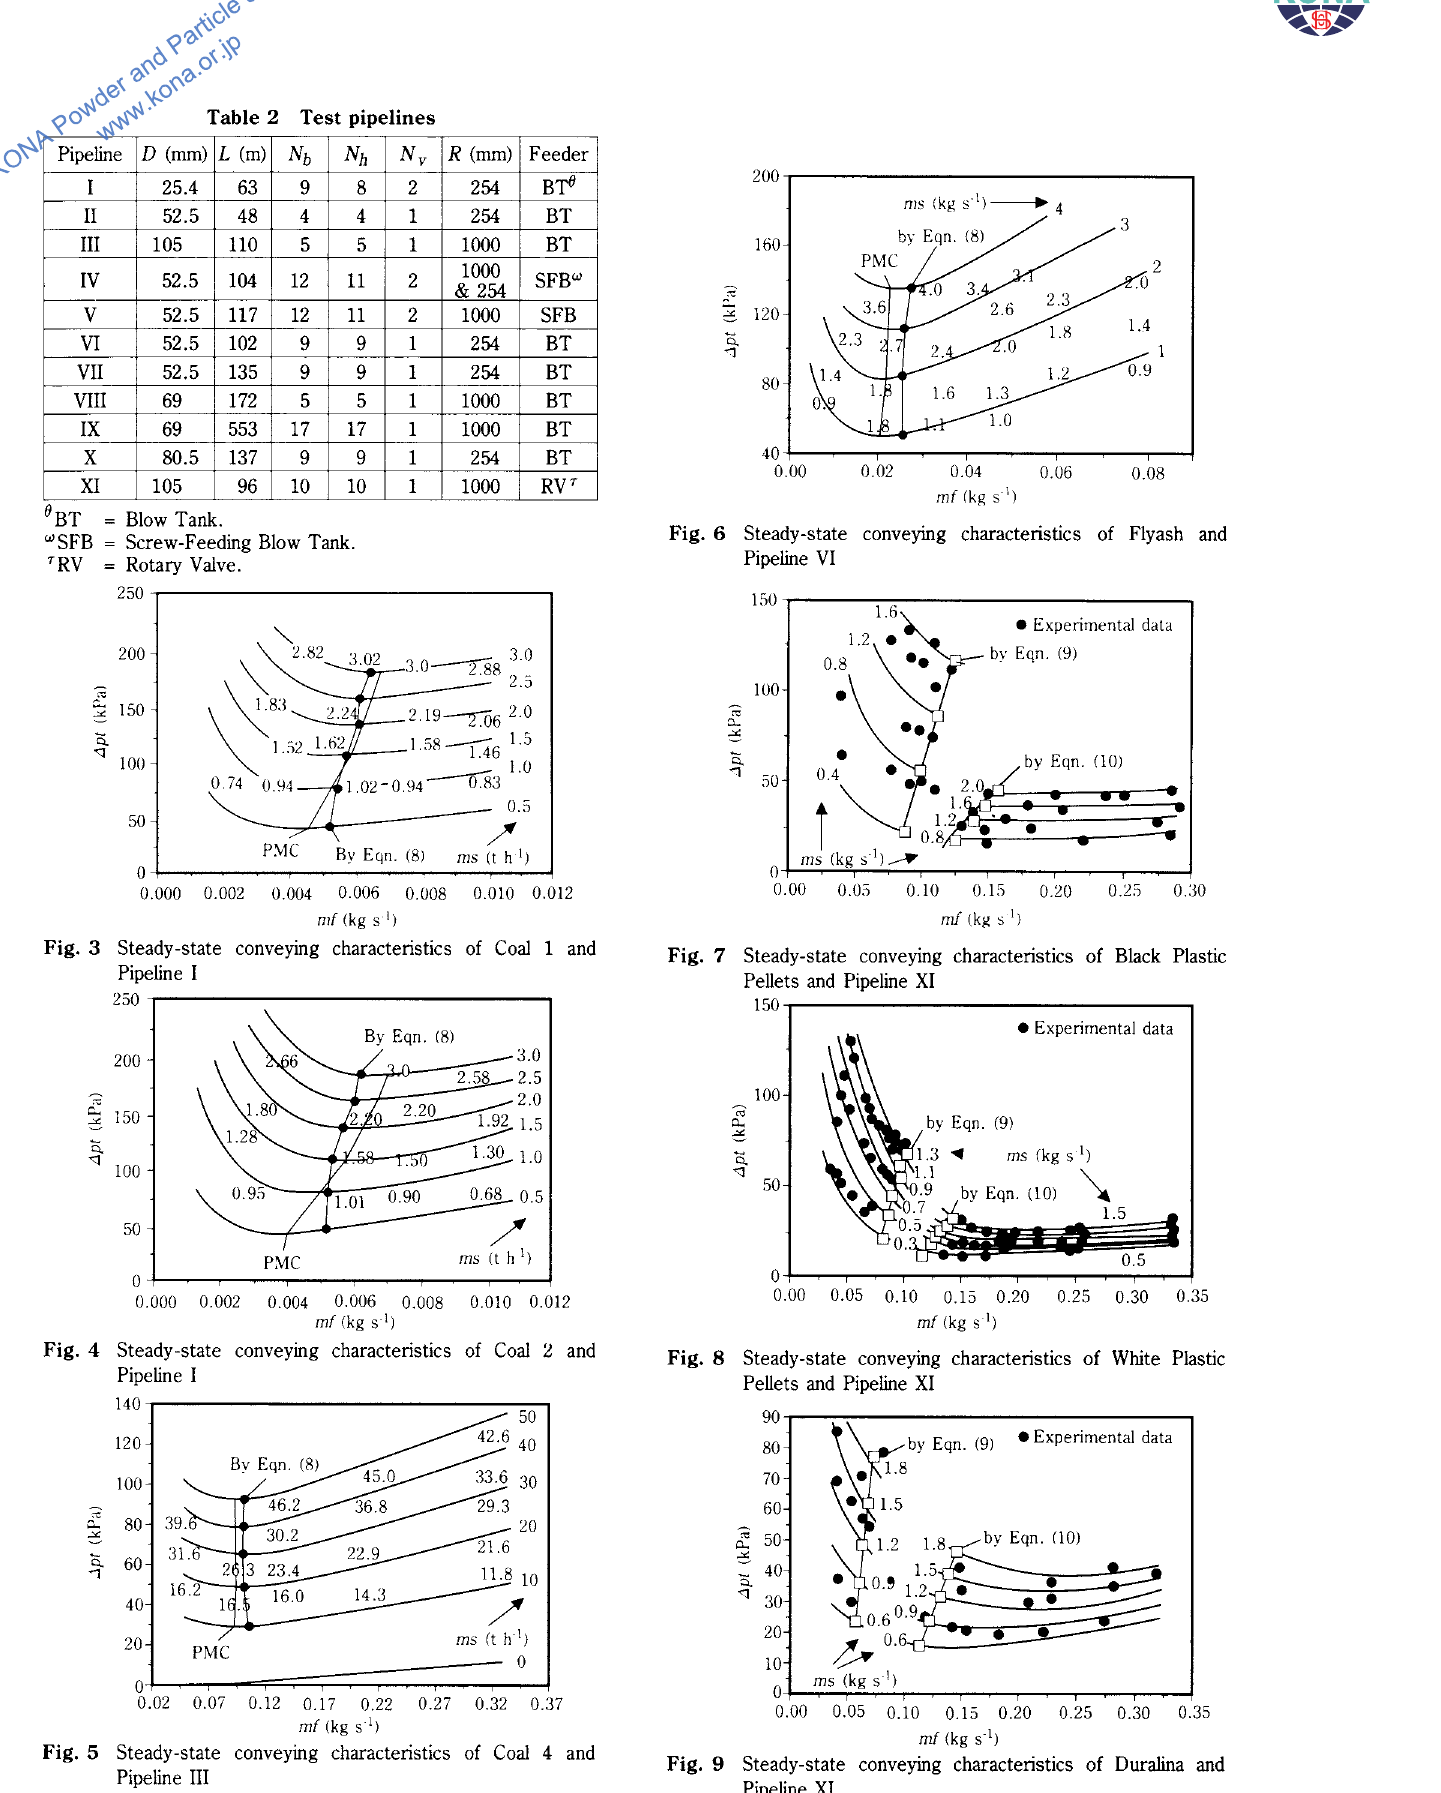
Fig. 9 Steady-state conveying characteristics of Duralina and Pipeline